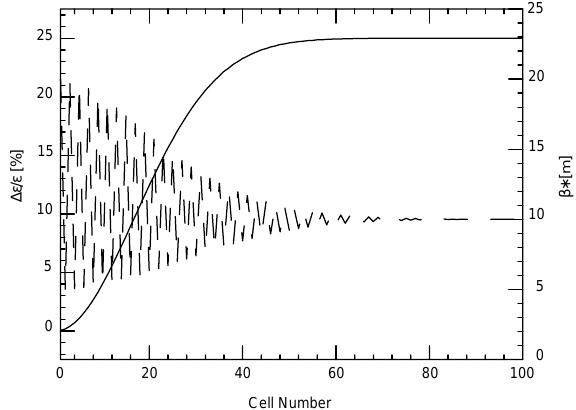
FIG. 7. Filamentation of a mismatched beam with a 1% energy spread in 100 90 ± FODO cells and an initial b (cid:1) (cid:1) 2 b ; the emittance dilution (solid) increases as the beam filaments while the beam beta function b (cid:1) (dashes) approaches the periodic lattice beta